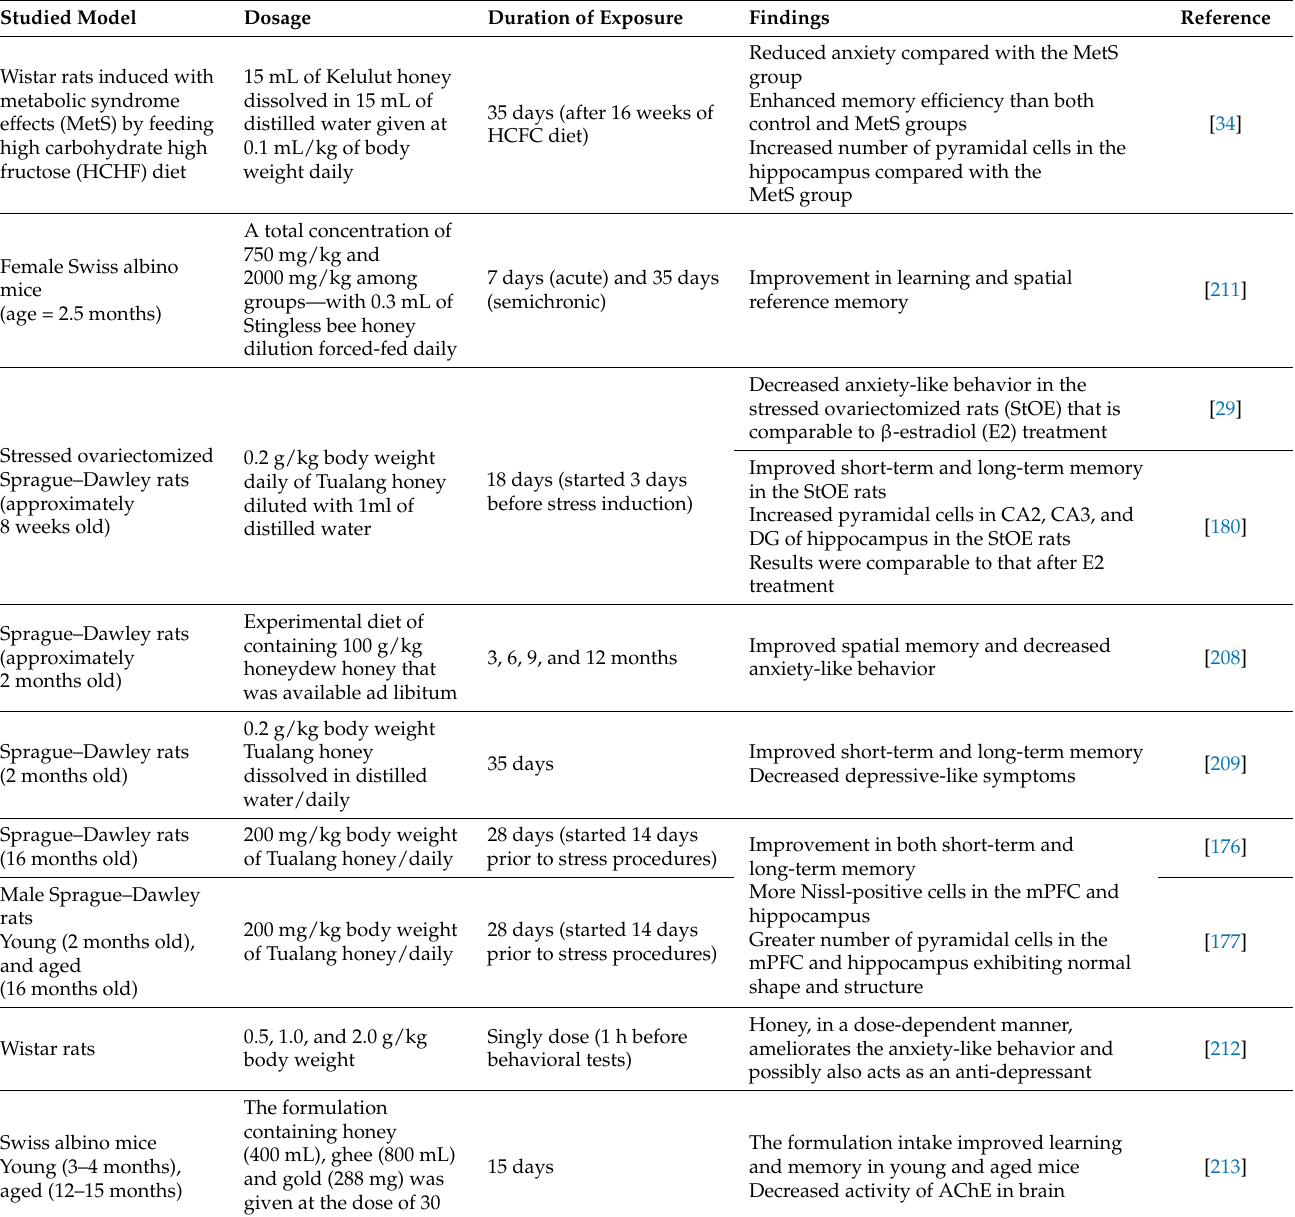
Table 3. Effects of honey intake on memory and cognition in animal